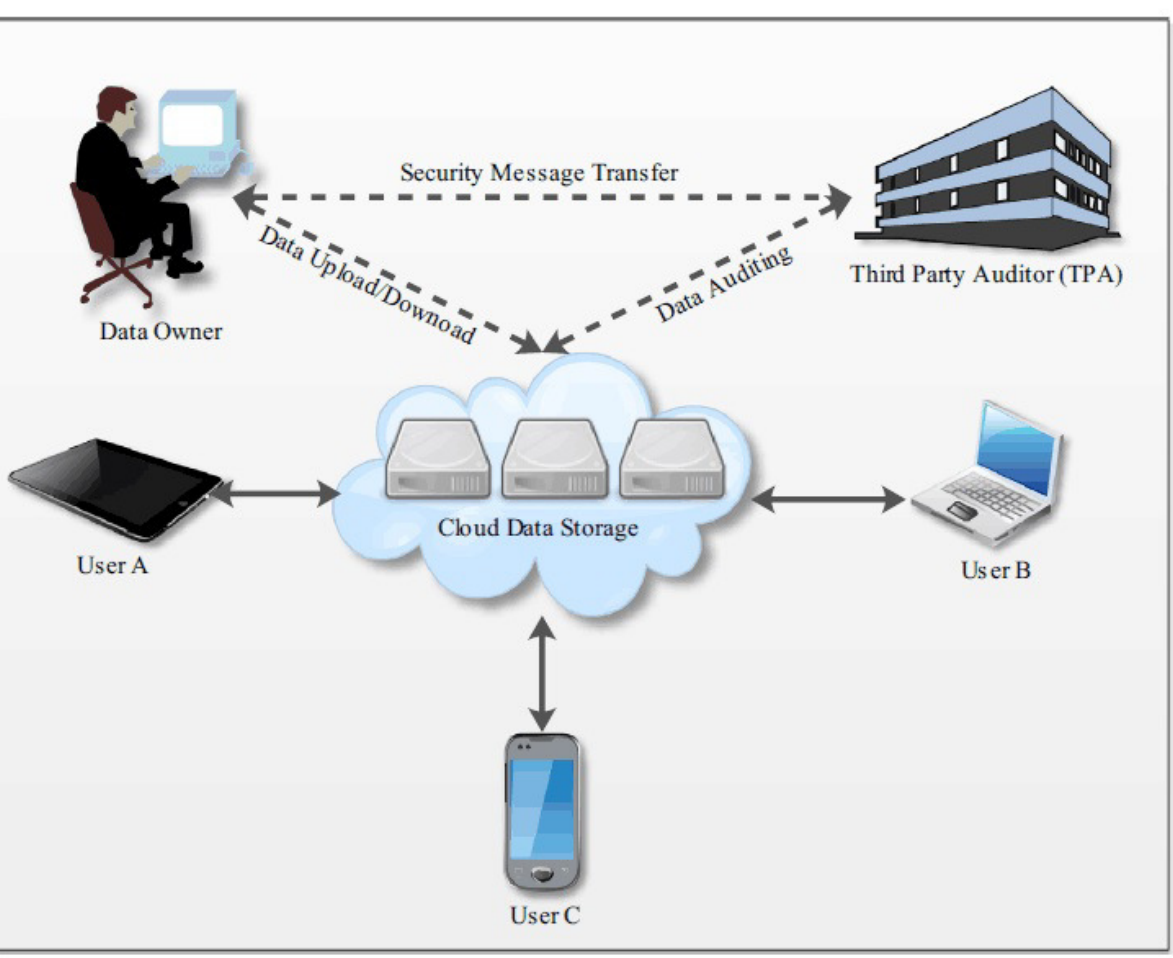
Fig. 3 Cloud data storage audit